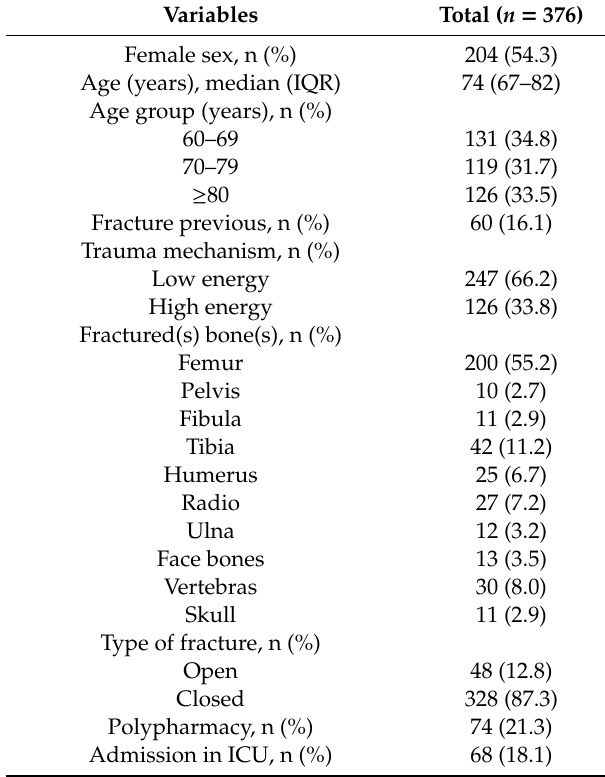
Table 1. Characteristics of the fractured elderly admitted to an emergency hospital in Goi â nia, Central Brazil (2016 /